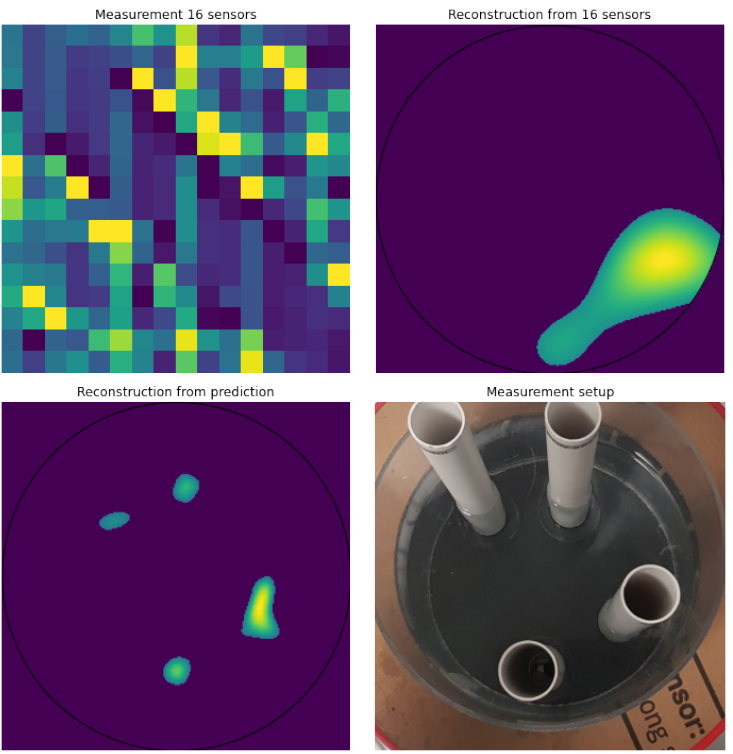
Figure 7. The results were obtained from real measurements with four phantoms located in the circular tank with four